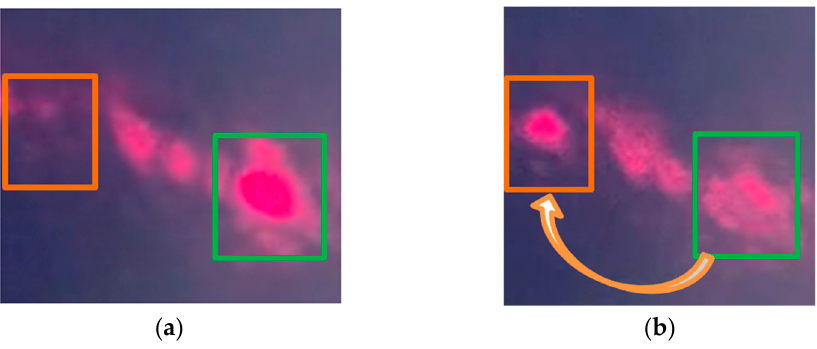
Figure 9. ( a ) Far-field image of a higher-order diffracted laser beam spot from the OPA during unactuated state; ( b ) far-field image showing a change of the laser beam spot position along the scan line caused by applying a different phase-shift pattern to the OPA micromirrors.